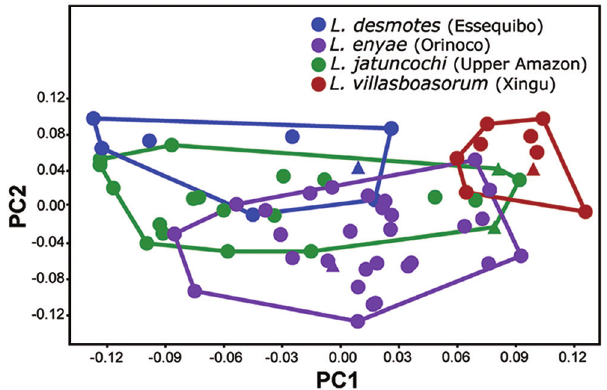
Fig. 3. Scatterplot of principal component 1 (PC1) versus principal component 2 (PC2) in the size corrected morphospace for Leporinus villasboasorum (brown), L. enyae (purple), L. desmotes (blue), and L. jatuncochi (green) showing separation of species centroids, but partial overlap of morphologies. Triangles represent individuals used in genetic analyses.